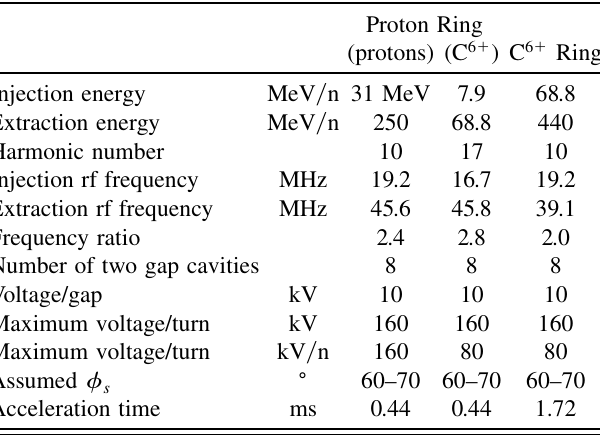
TABLE X. Summary of parameters of the rf cavity.